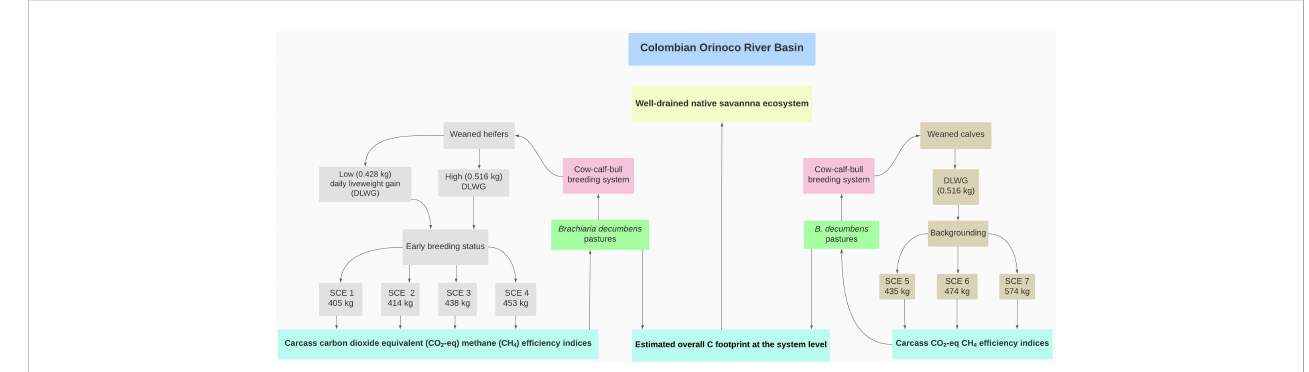
FIGURE 1 Boundaries and fl ows of young-Brahman fattening farming systems under